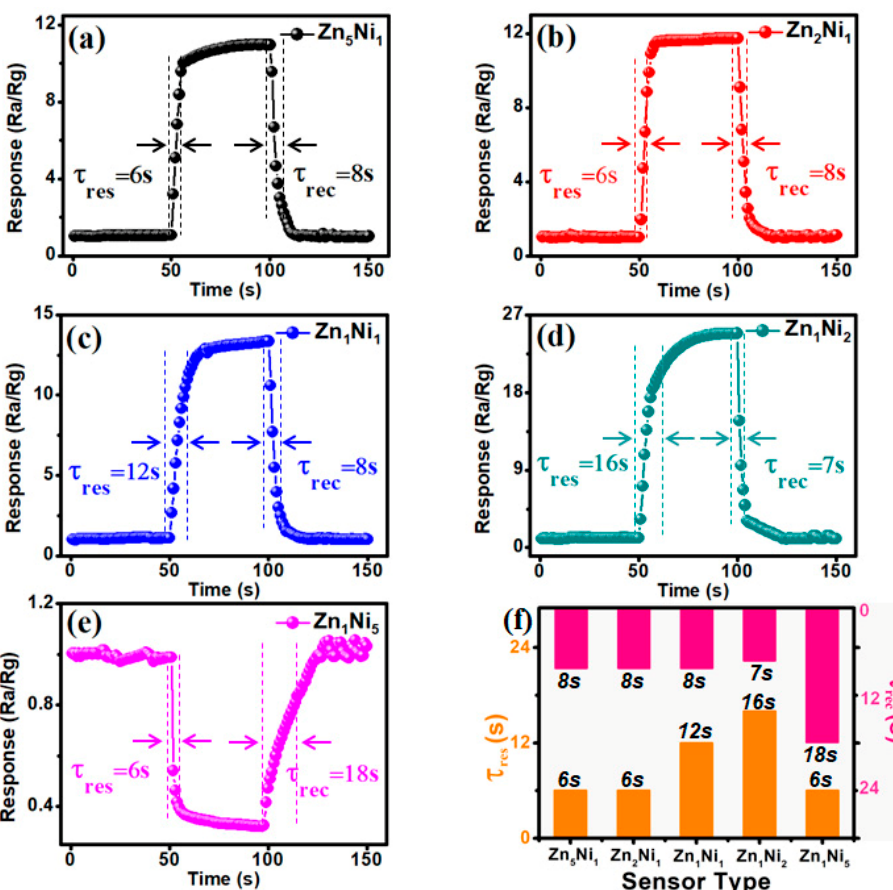
Figure 9. Dynamic sensing transient of n -ZnO / p -NiO based sensors toward 100 ppm NH 3 : Zn 5 Ni 1 ( a ), Zn 2 Ni 1 ( b ), Zn 1 Ni 1 ( c ), Zn 1 Ni 2 ( d ) and Zn 1 Ni 2 ( e ). ( f ) Response and recovery times of sensors. Table 1. Comparison of the sensing performance of various gas sensors toward NH 3 .